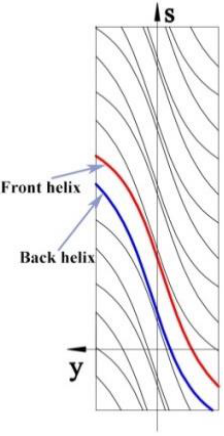
Figure 3. Structural diagram of SSE.